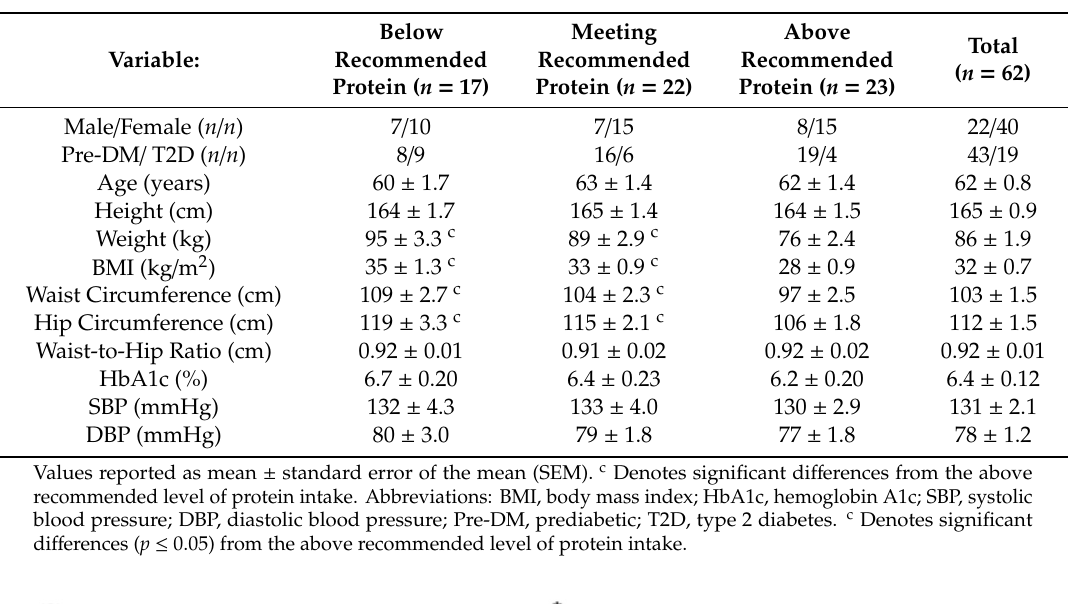
Table 2. Demographic information and anthropometrics.